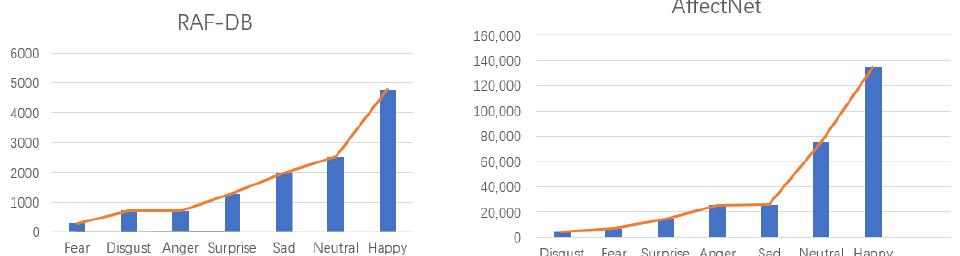
Figure 2. RAF-DB and AffectNet are large-scale facial expression datasets, where happy and neutral expressions occupy the vast majority of facial expression data, and other expressions only account for a small part, which conforms to a long-tail distribution. A model trained on such a dataset seldom refers to the characteristics of tail expression